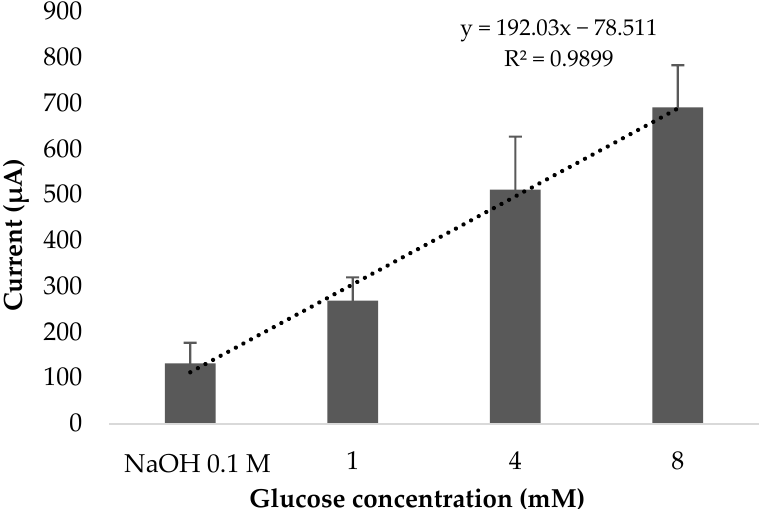
Figure 8. Reproducibility of copper oxide electrode. Data from 9 copper oxide electrodes synthesized with the same protocol and conditions.